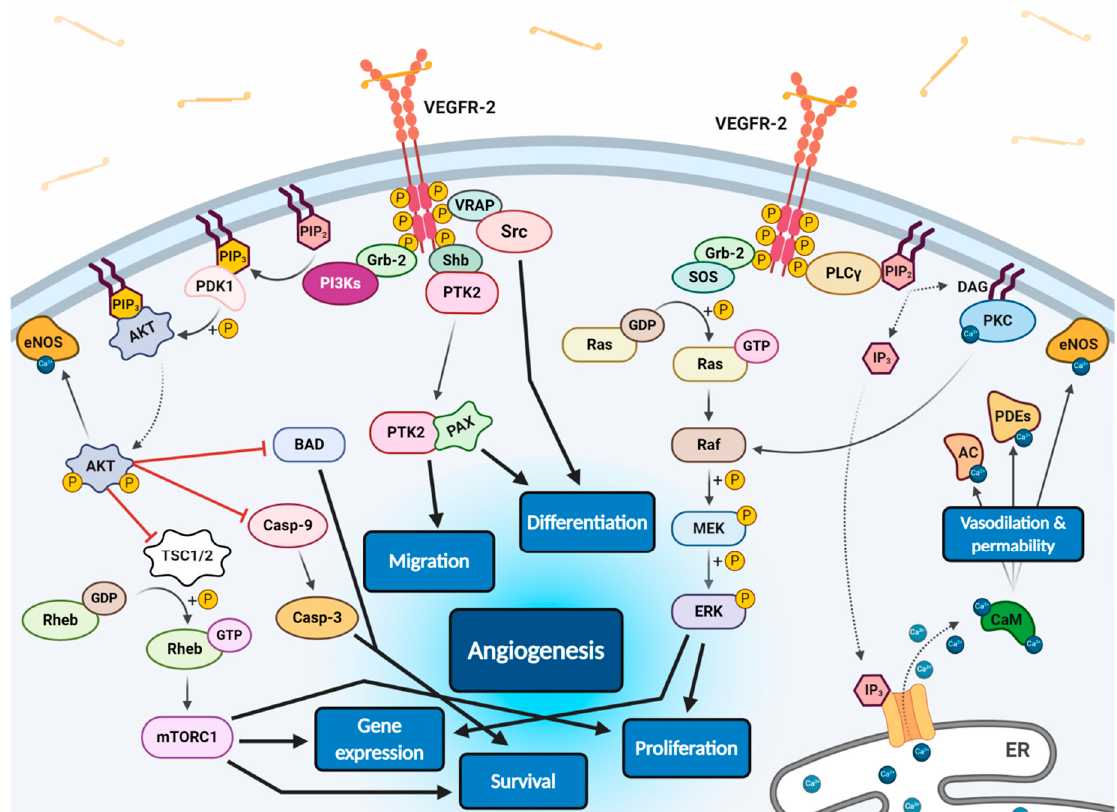
Figure 2. Scheme of endothelial signal transduction of VEGF-VEGFR-2 ligand-receptor molecular complex. The autophos- phorylation of receptor tyrosine kinase domains caused by VEGF binding stimulates multiple specific VEGFR-associated proteins (VRAPs) and adaptor molecules inducing concurrent intracellular signalling pathways that promotes proliferation, differentiation, migration, gene expression and apoptosis survival of endothelium leading to angiogenesis.